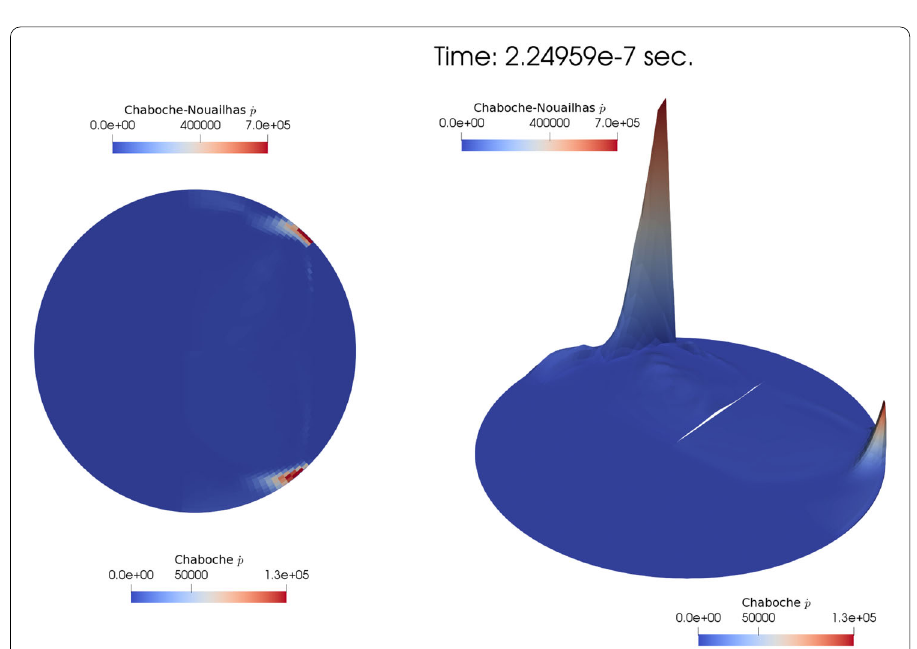
Fig. 25 Effective viscoplastic strain rate ˙ p in the inclusion at time 2 . 25 × 10 − 7 s, computed with Chaboche and Chaboche–Nouailhas’ viscoplastic constitutive models. Both unwarpped (left) and warpped (right) isovalues are presented, the latter being scaled with the same scale factor 10 − 9